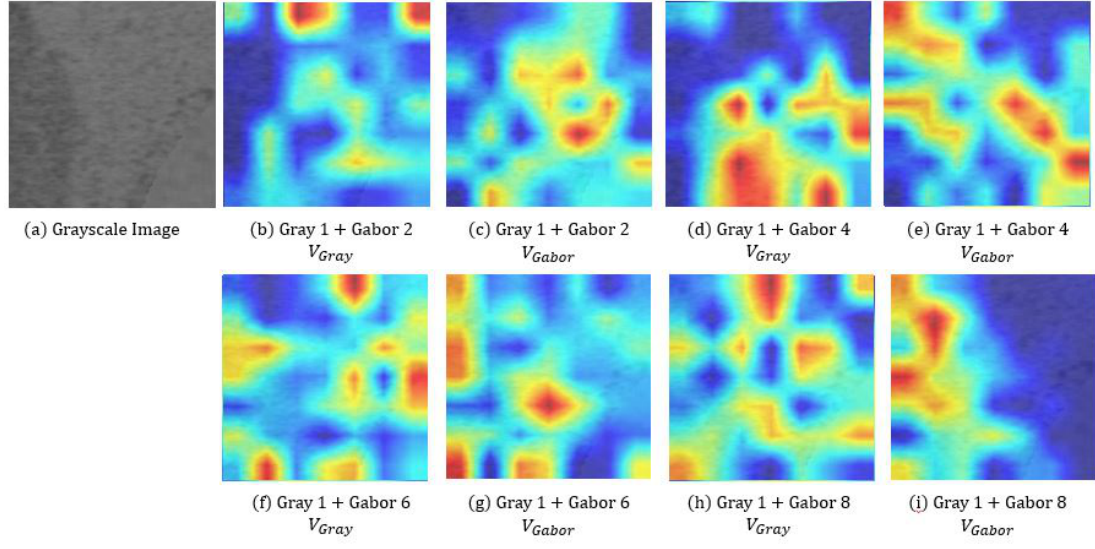
Figure 9. CAM image result for CCM Stain image in a Dual-stream